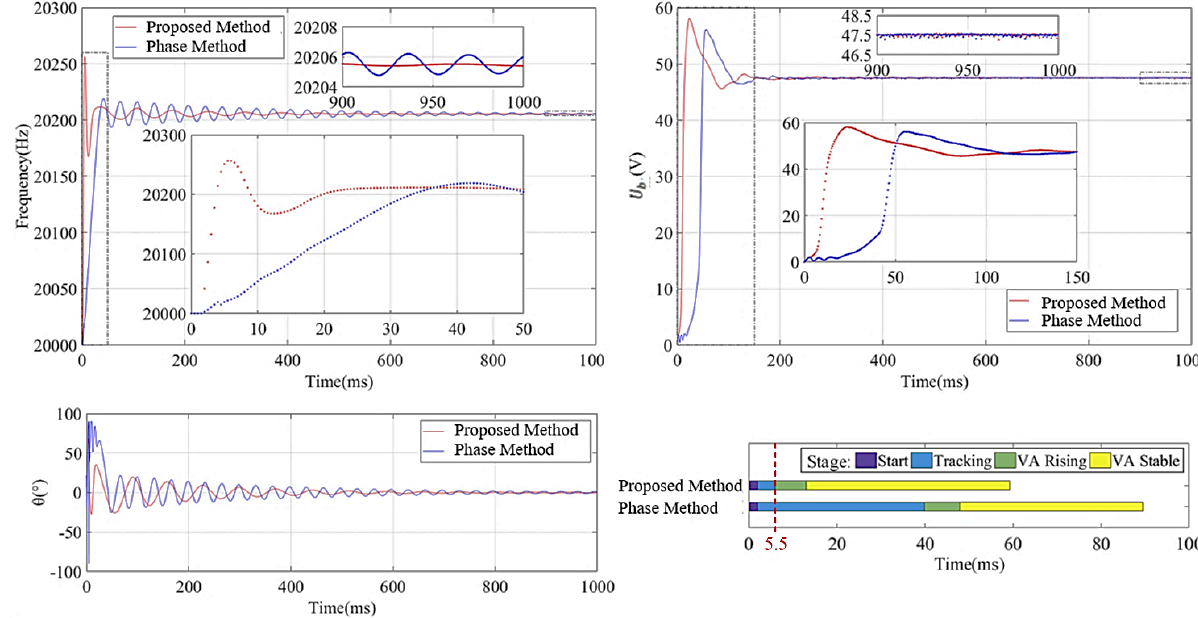
Figure 12. Comparison with the phase method under no-load condition.